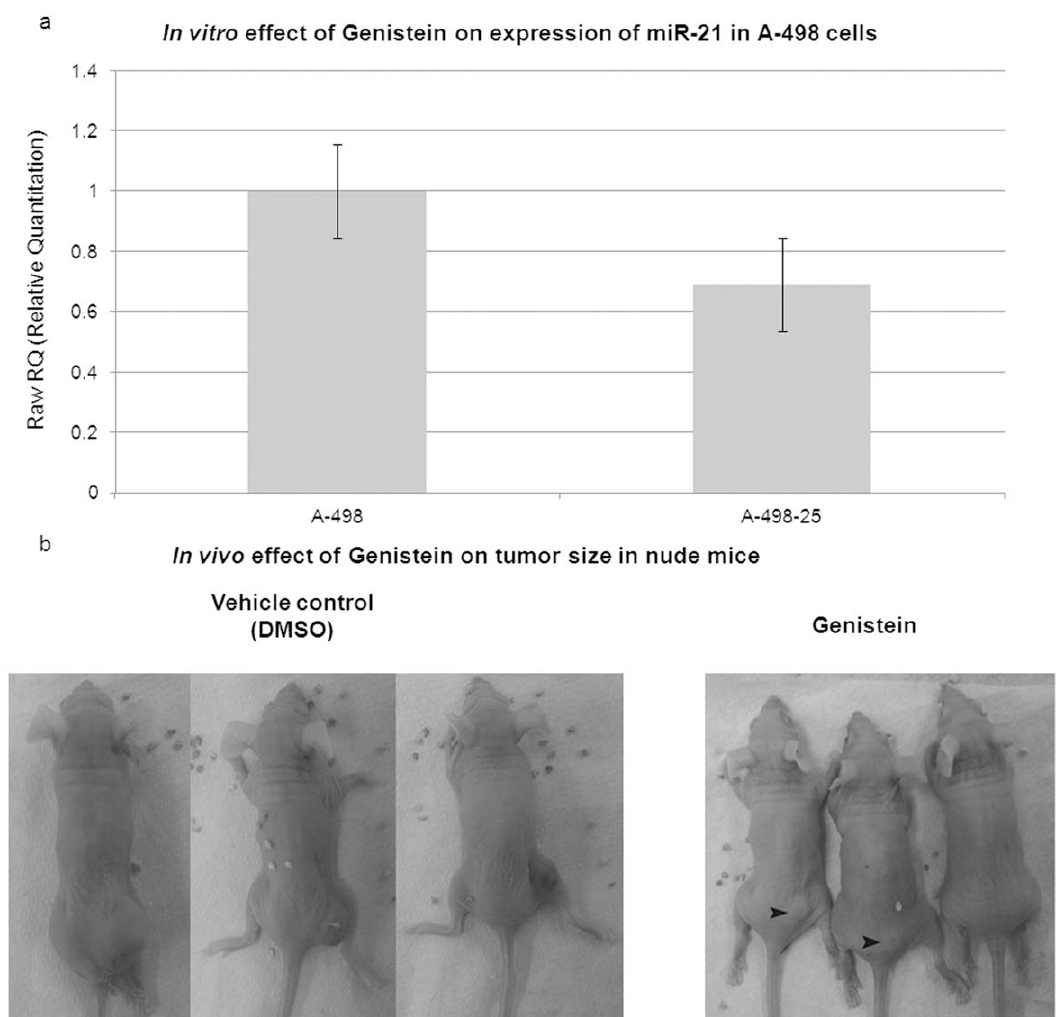
Figure 5. Invitro and Invivo effect of genistein on the expression of miR-21. (a) Effect of genistein (25 m M) on the expression of miR-21 in A- 498 cells: miR-21 expression was found to be reduced by , 30% in genistein treated A-498 cells as compared to untreated cells. (b) In vivo effect of genistein on tumor size in nude mice: Genistein was able to reduce tumor formation significantly (black arrows, right panel). doi:10.1371/journal.pone.0031060.g005 protein expression of different cyclin dependent kinases CDK4, E1 and E2 and could find a difference in only cyclinE2 (Figure 4).